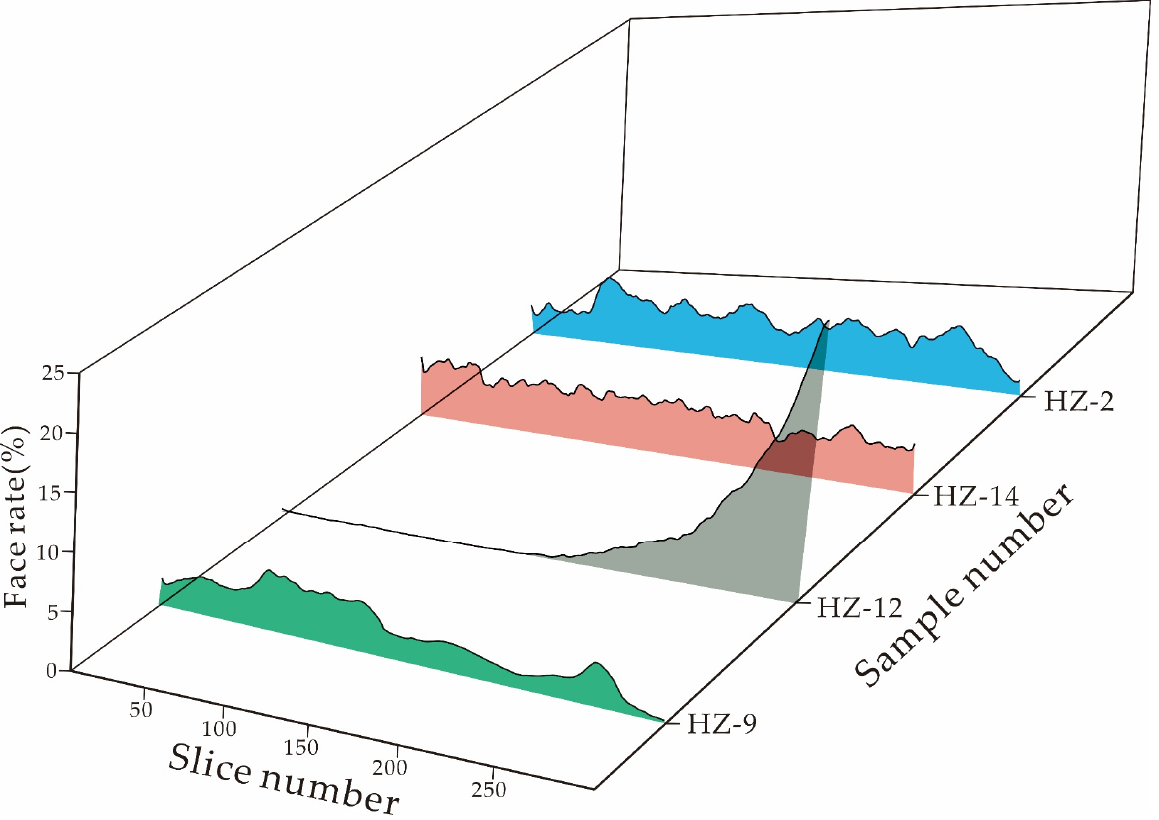
Table 6. Pore throat structure parameters of the carbonate rock samples in the Huize lead–zinc deposit.